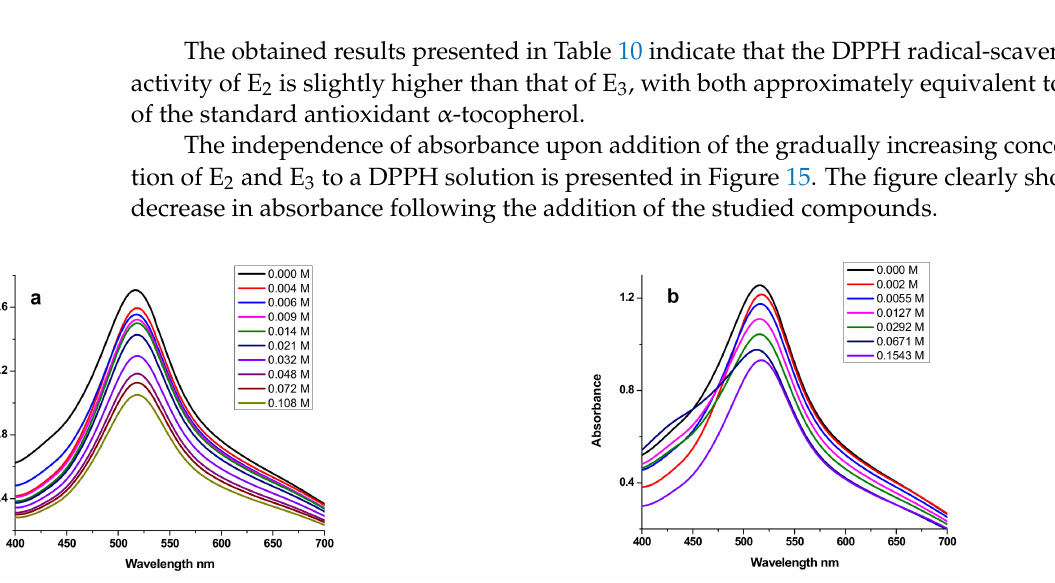
Figure 15. UV-visible absorption spectra of a solution of DPPH (2 mg) in 10 mL acetonitrile in the presence of increasing concentrations of polysaccharidic extracts in acetonitrile at 298 K: ( a ) E 2 ; ( b ) E 3